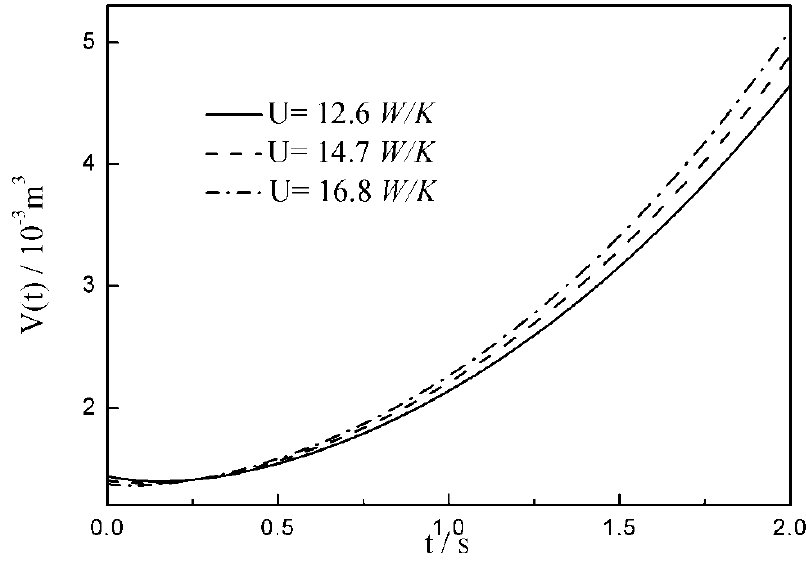
Figure 3. Optimal volume versus time as n = 1.